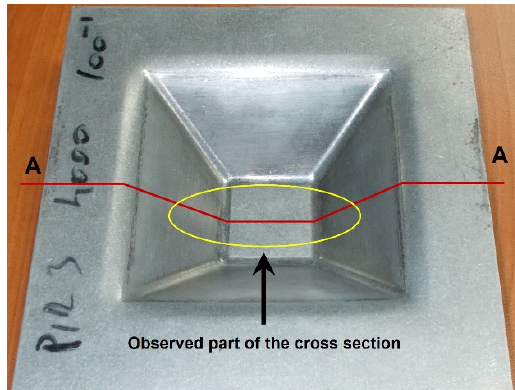
Figure 3. Geometry of a workpiece.